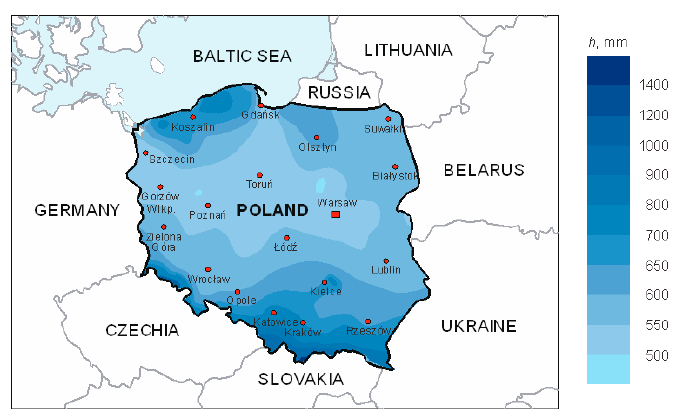
Figure 3. The 19 analysed cities on the map of annual precipitation in Poland.